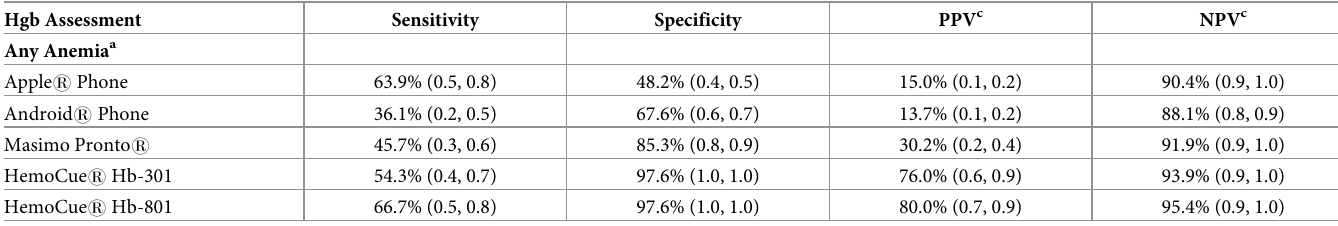
Table 3. Classification bias of hemoglobin measurement devices for any anemia a,b